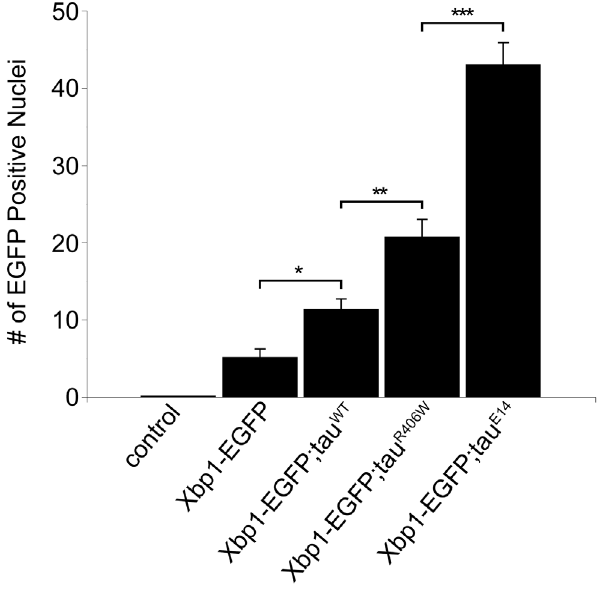
Figure 2. Quantitative analysis of Xbp1-EGFP reporter activity. Significant activation in tau transgenic flies, with the degree of activation correlating with the degree of toxicity of various forms of human tau, including wild-type tau (tau WT ), FTDP-17 linked mutant tau R406W and the phosphomimic mutant tau E14 . No immunoreactivity for GFP in control animals ( elav - GAL4 / + ). *P , 0.05, **P , 0.01, *** P , 0.001, one-way ANOVA with Tukey test for multiple comparisons. Flies are 10 days old.